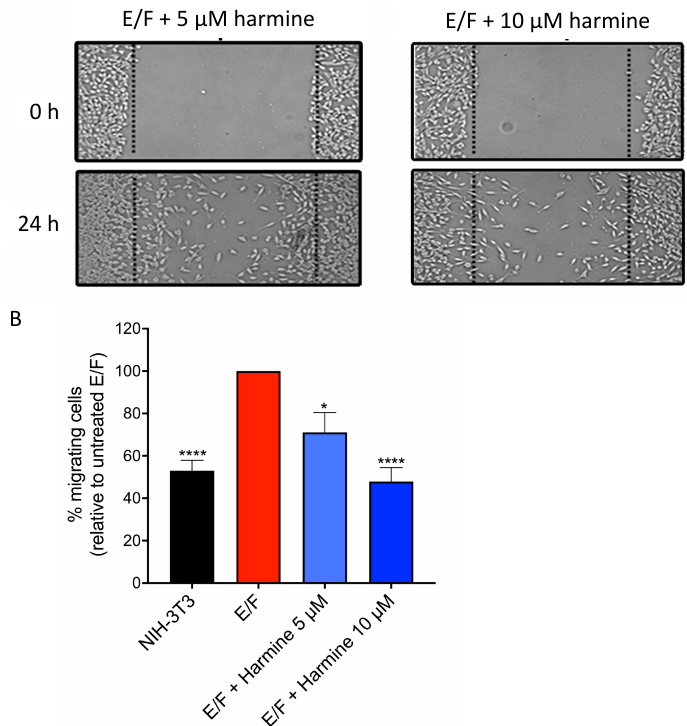
Figure 5. Effect of harmine on E/F cell motility. NIH-3T3 and E/F cells were cultured for 48 h to reach confluency in the presence or absence of harmine, then a wound was made in the monolayer. Cell migration was examined during 24 h by phase-contrast light microscopy. The images of wound repair were taken at 0 h and 24 h after wound. ( A ) Representative images. ( B ) Quantification of the cells that migrated from the wound edges into the wounded area. The results are the means ± SEM for four independent experiments. * p < 0.05; **** p < 0.0001 versus control untreated E/F cells.